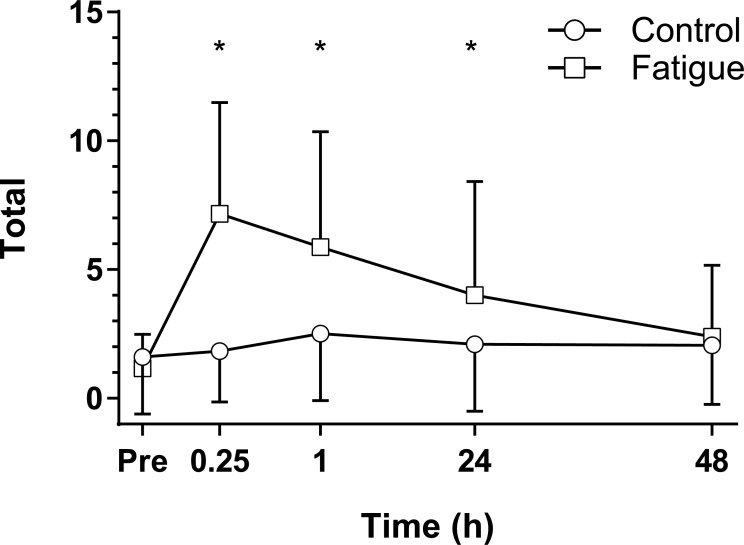
Neuromuscular fatigue questionnaire results.The mean (SD) neuromuscular fatigue questionnaire responses (n = 30) for the control (circles) and fatigue interventions (squares) from immediately prior (Pre) to 48 h post condition. *Significant (p < 0.05) difference between conditions at the identified time point using a Benjamini-Hochberg post hoc procedure.